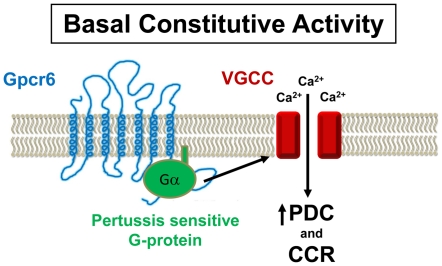
Proposed signaling model.The wild-type Gpcr6p causes constitutive activation of a pertussis sensitive G-protein that modulates the opening of the ciliary voltage-gated Ca2+ channels (VGCC). Since these channels provide the Ca2+ for Ca2+-dependent ciliary reversals, this makes the basal percent of cells showing direction changes (PDC) relatively high in unstimulated wild-type. Chemoattractants act as inverse agonists to decrease G-protein activation, lower the basal PDC and cause straighter forward swimming towards the attractant. Strong depolarizations cause prolonged Ca2+ channel activation, continuous ciliary reversals (CCR) and backward swimming. In both the G6 mutant and the wild-type with pertussis toxin, this G-protein activation is missing so there is a lower basal PDC, no chemoattraction and decreased CCRs in high concentrations of either Ba2+ or K+.